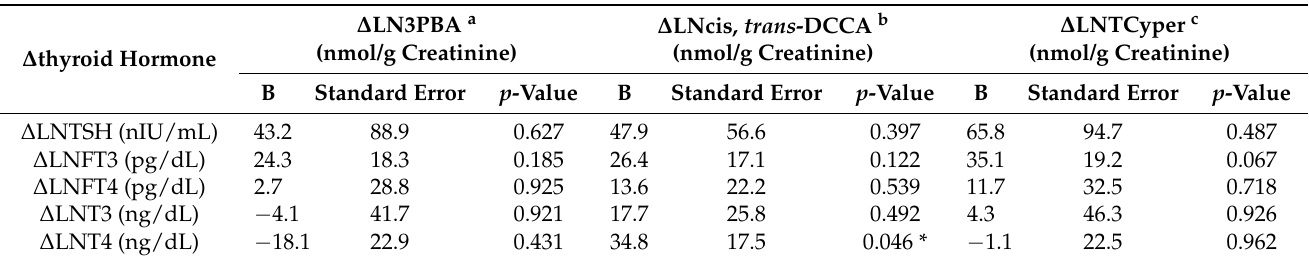
Table 8. Model for change in thyroid hormone levels (logged morning after spraying—logged morning before spraying) as a function of the change in urinary metabolite levels for sprayed insecticide cypermethrin (logged morning after spraying—logged morning before spraying).